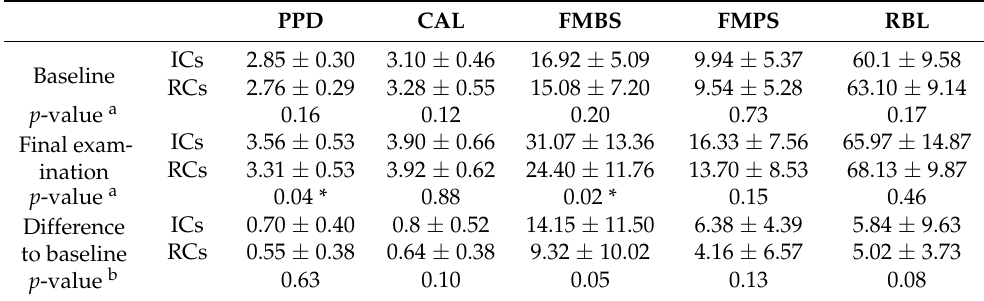
Table 5. Baseline and final examination intergroup comparisons between RCs and ICs regarding periodontal parameters.